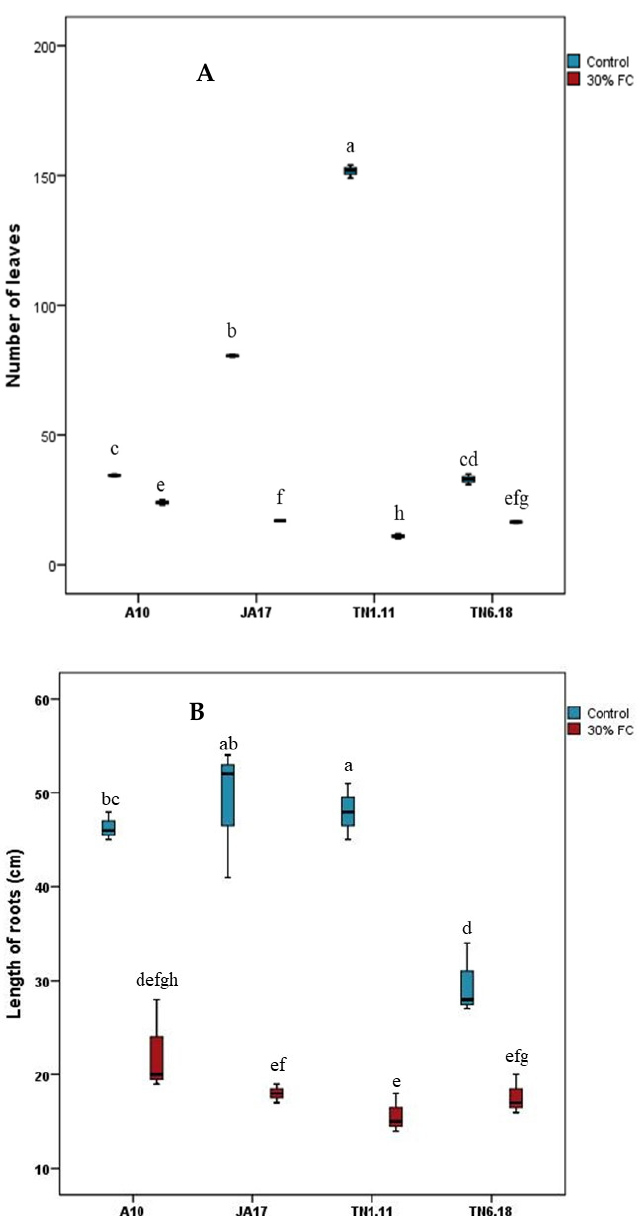
Figure 1. Number of leaves ( A ) and length of roots ( B ) for the four lines of M. truncatula under control treatment and 30% FC. Means followed by the same or a common letter (s) are not significantly different among the studied lines for each trait according to Duncan’s test at 5%.